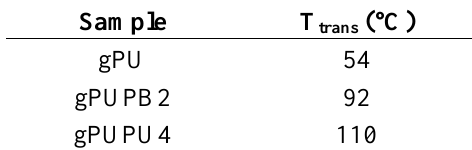
Table 3. Transition temperature of SMPU with amorphous